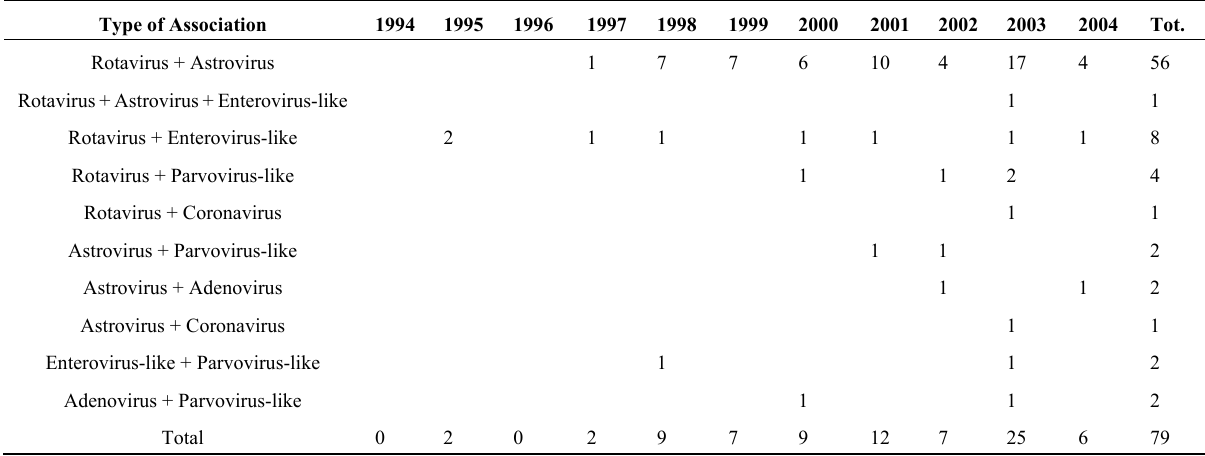
Table 4. Number and type of multiple infections (association of two of more viruses) observed using